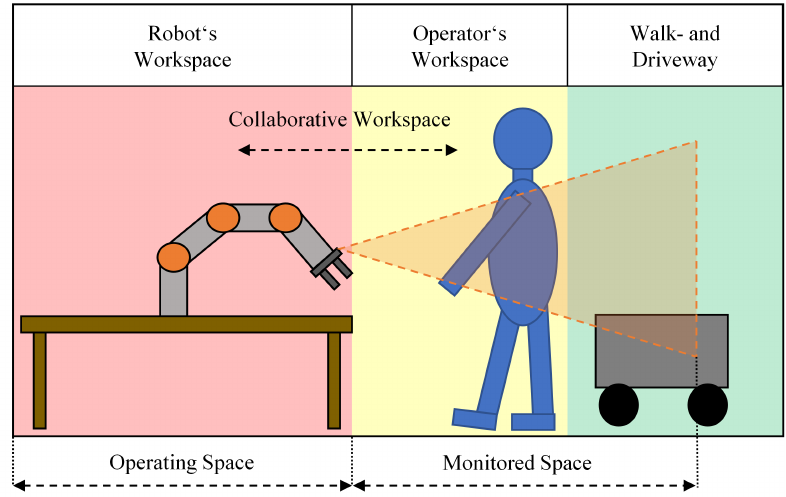
Figure 2. Different workspaces around a robotic application. Note how the monitored space ranges into the walkway and driveway